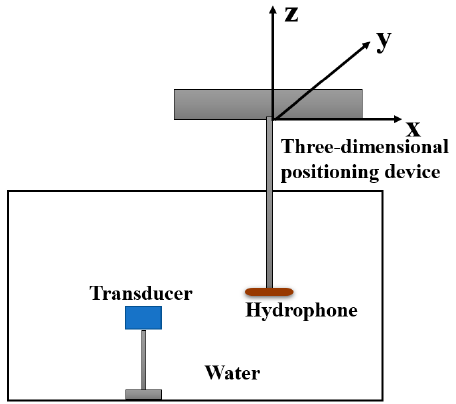
Figure 10. Acoustic pressure measurement setup using a hydrophone.